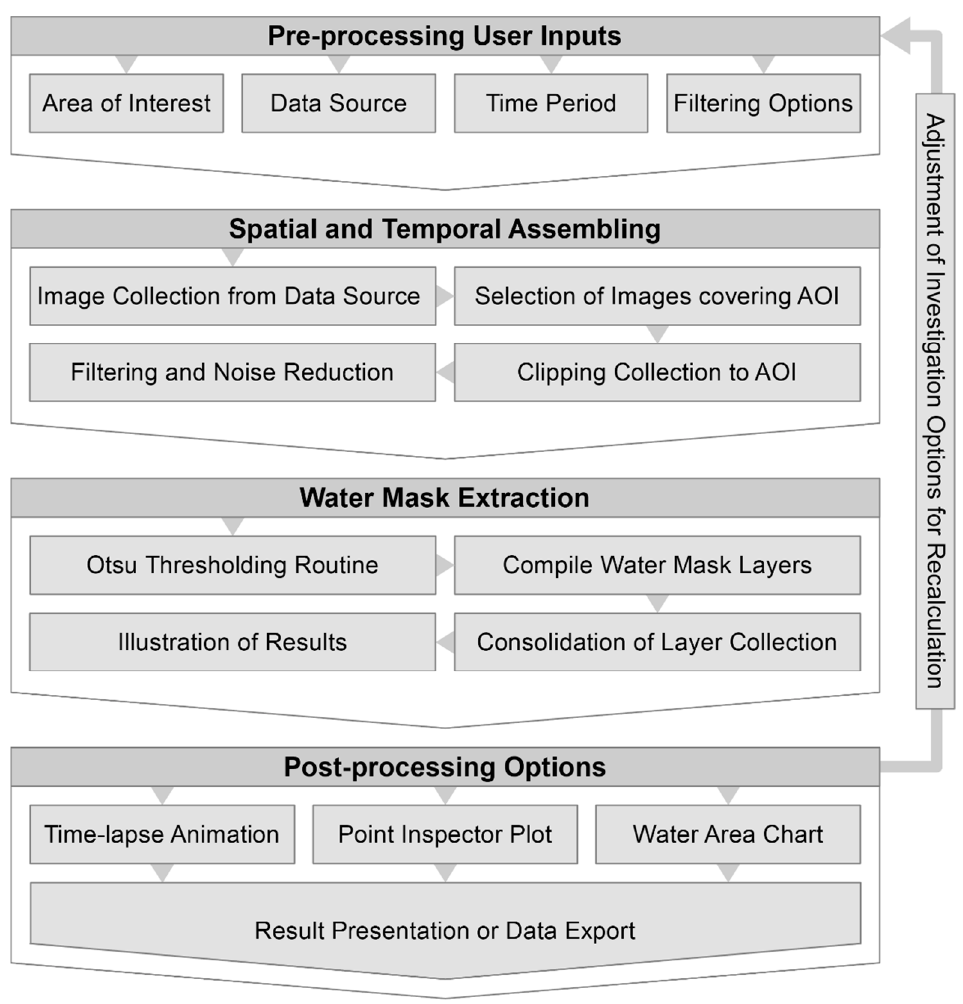
Figure 4. Processing scheme of WMA.